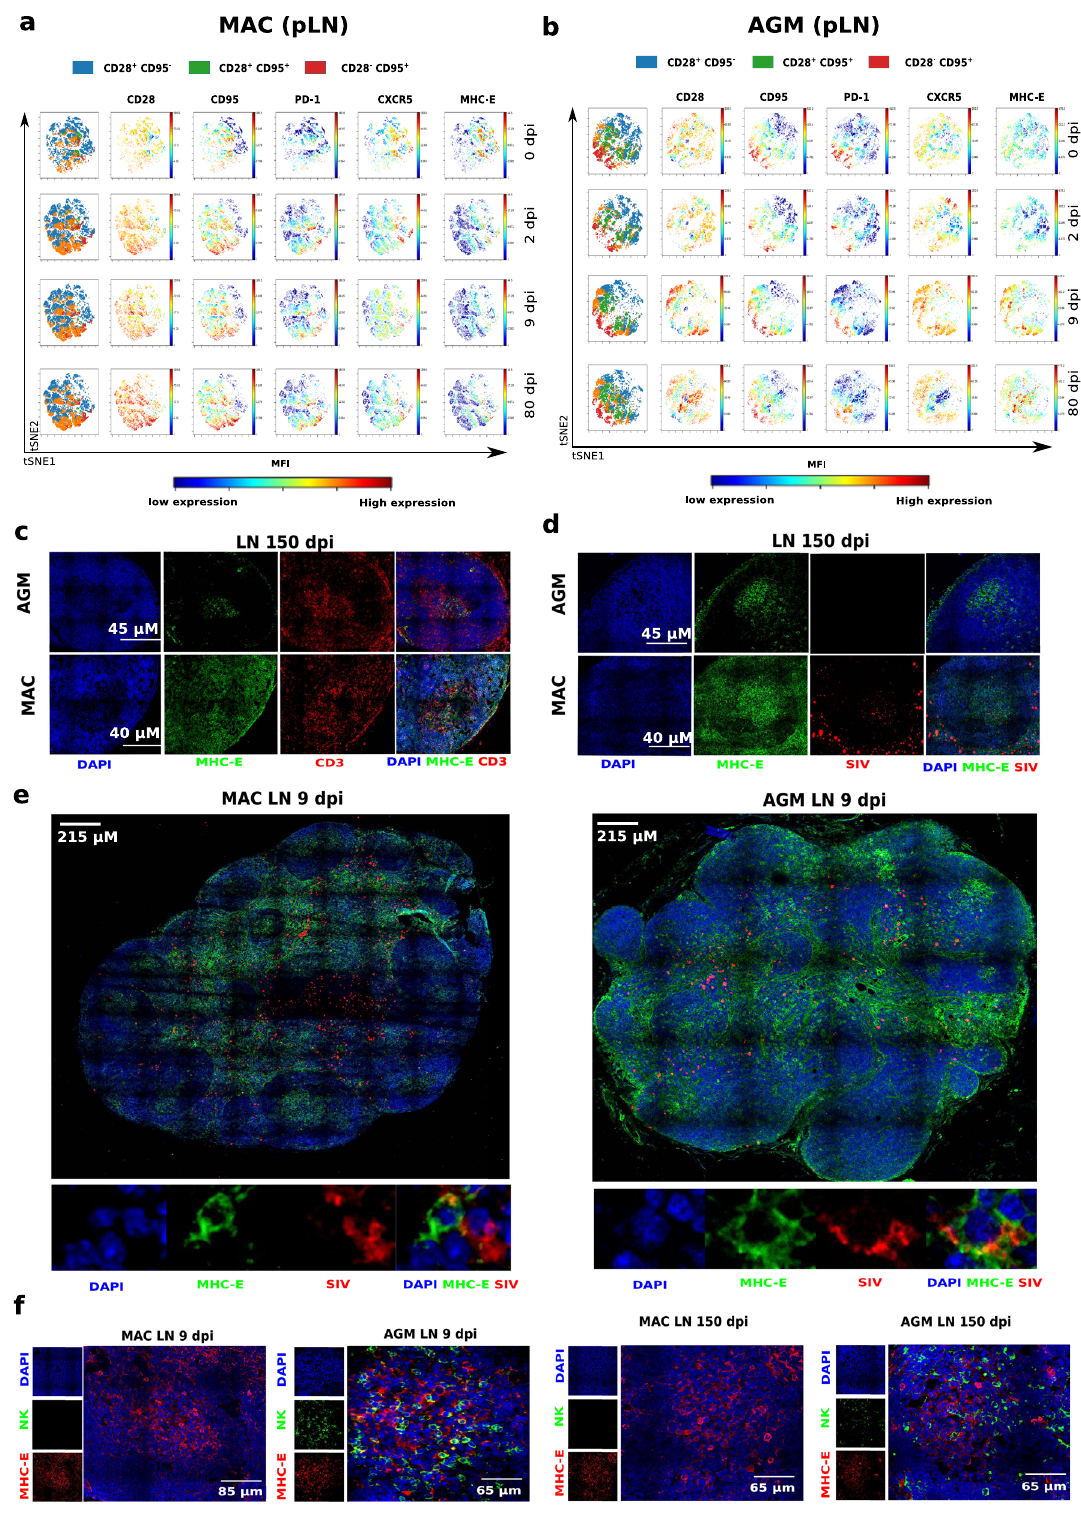
We fi rst studied NK cells from uninfected AGM and MAC. NK cells were co-cultured with K562-E * 0101 cells pre-loaded or not with the peptides and their activity was measured by CD107a expression (Fig. 7c, d). As expected, the HLA-I-derived VL9 peptide inhibited NK cell activity, while the HSP60 peptide did not, validating our assay. When pulsing the cells with the SIVmac ENV peptide, NK cell activity from both MAC and AGM